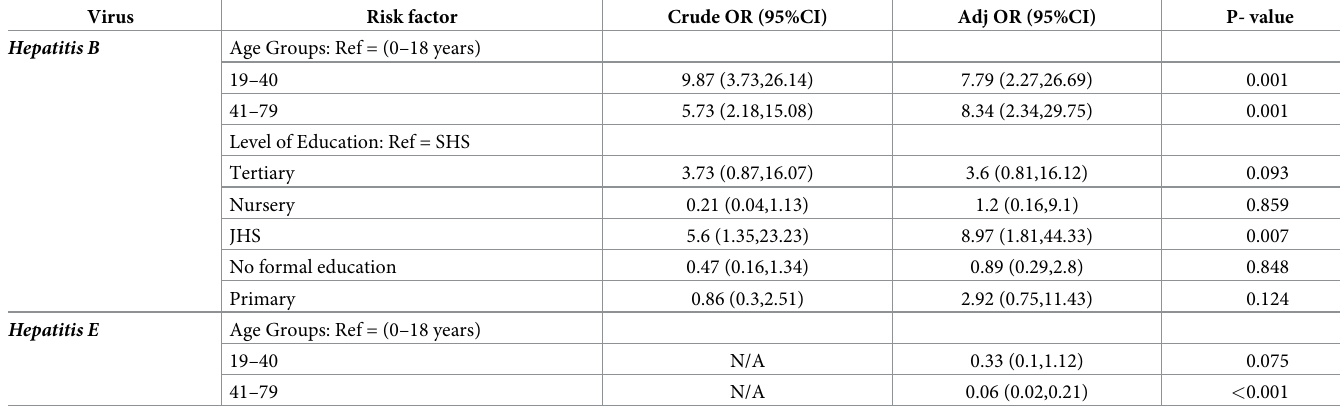
shown). For patients infected with HEV, the average creatinine level was higher (median = 71 μmol/l; IQR = 51–100.8) than those not infected (p = 0.023). Of the 155 patients, 5 died. Of the 5, 1 was infected with HEV and three were infected with HBV infection. To determine the independent risk factors associated with exposure to hepatitis viruses, all variables with p-value below 0.2 were entered into three logistic regression models each for hepatitis B, C and E virus exposures. Age and level of education were identified to be indepen- dent risk factors associated with hepatitis B and E infections. No significant factors were asso- ciated with hepatitis C virus exposures. Table 6 describes the independent risk factors associated with hepatitis viruses. Table 6. Independent risk factors of hepatitis virus exposure.